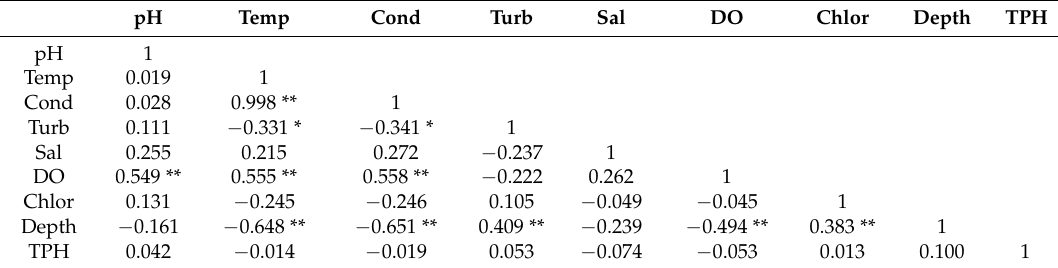
Table 4. Matrix of Pearson correlation among water quality